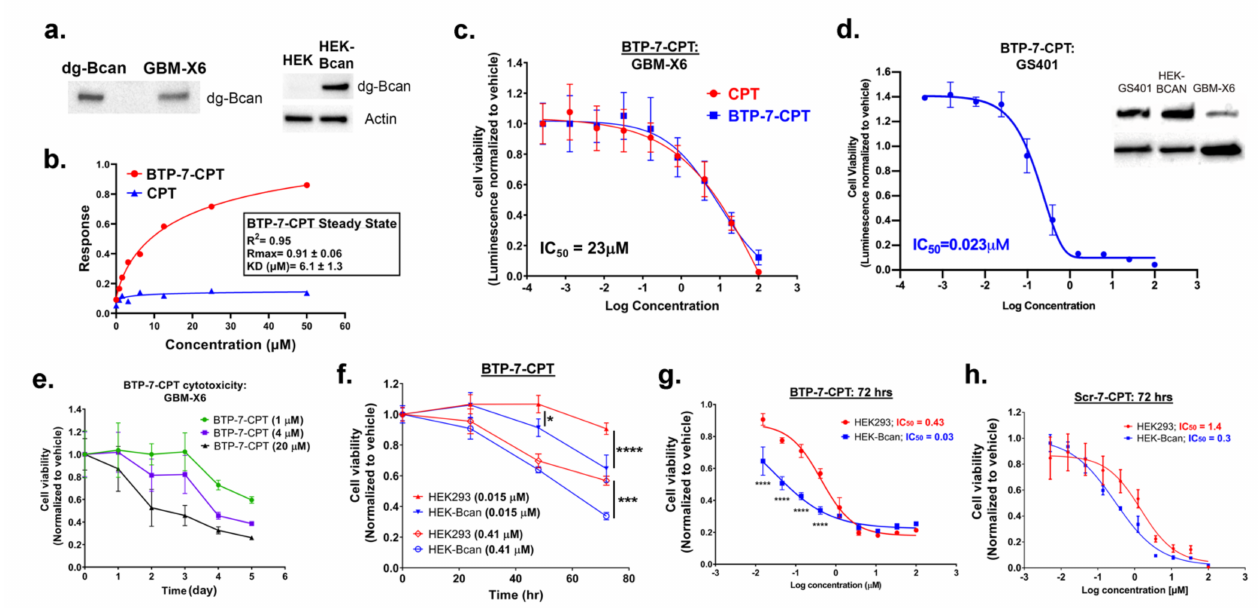
Figure 3. Cytotoxicity of BTP-7-CPT. ( a ) Western blot showing expression of dg-Bcan in patient- derived GBM-X6 cells, as well as in Bcan-overexpressing HEK cells (HEK-Bcan). ( b ) Binding kinetics analysis (steady-state) of BTP-7-CPT (red) and unmodified CPT (blue) to recombinant dg-Bcan protein using the ForteBio Octet system. R max (maximal response in response unit) and K D (dissociation constant) were calculated using a non-linear regression (one site specific binding) fit using the Graphpad Prism software. ( c ) Luminescent cell viability (CellTiter-Glo) of GBM-X6 cells treated with BTP-7-CPT (n wells = 3) for 72 h. ( d ) Luminescent cell viability (CellTiter-Glo) of GS401 recurrent GBM cells treated with BTP-7-CPT (n wells = 3) for 72 h. All IC 50 values were measured through the non-linear ‘log(inhibitor) vs. response—variable slope (four parameters)’ fit. Western blot (right) shows higher expression of dg-Bcan in GS401 cells than in GBM-X6. ( e ) CellTiter-Glo assay of GBM- X6 cells treated with BTP-7-CPT at 1, 4, or 20 µ M (n wells = 3) over 5 days. ( f ) CellTiter-Glo assay of HEK293 (red) or Bcan-overexpressing HEK (HEK-Bcan) cells (blue) treated with BTP-7-CPT at 0.015, or 41 µ M (n wells = 3) over 3 days. ( g , h ) CellTiter-Glo assay of HEK-Bcan cells (blue) and